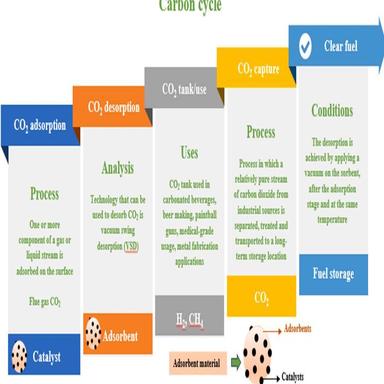
The Schematic diagram of ICCU and its advantages over to the CCU and CCS processes.